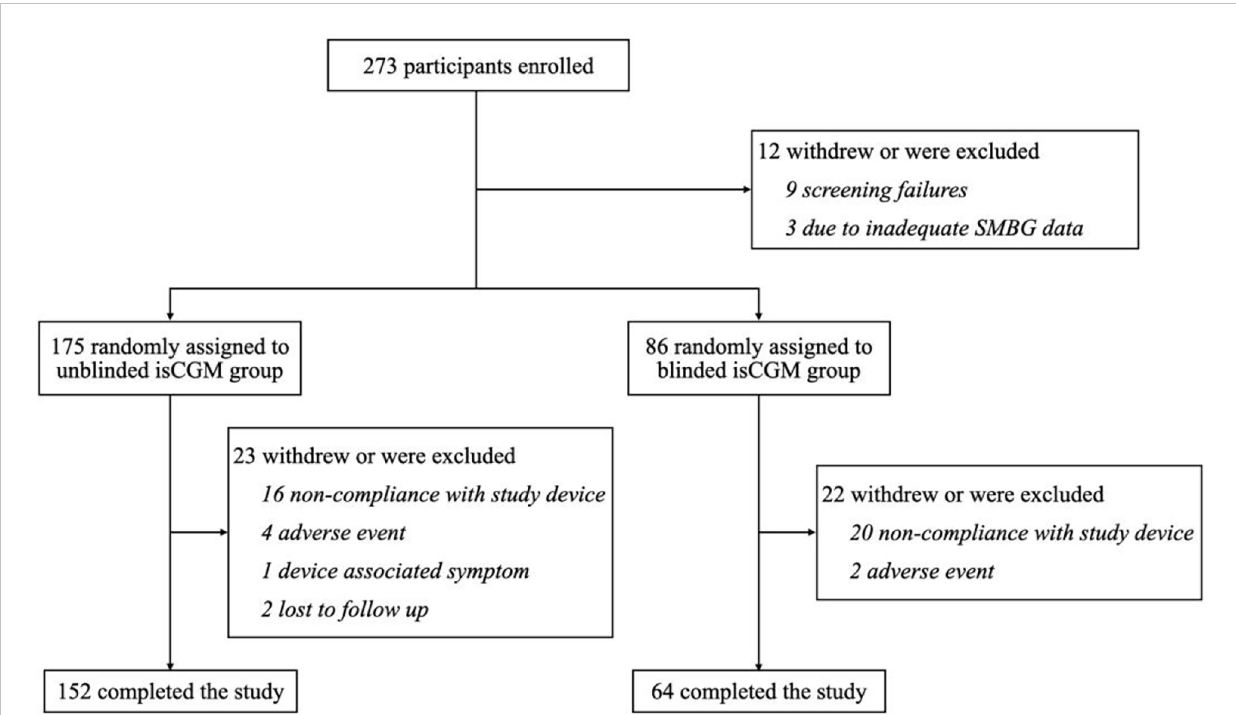
FIGURE 2 fl ow of participants in a study of the ef fi cacy of unblinded and blinded intermittently fl ash continuous glucose monitoring on glycemic control in adults with type 1